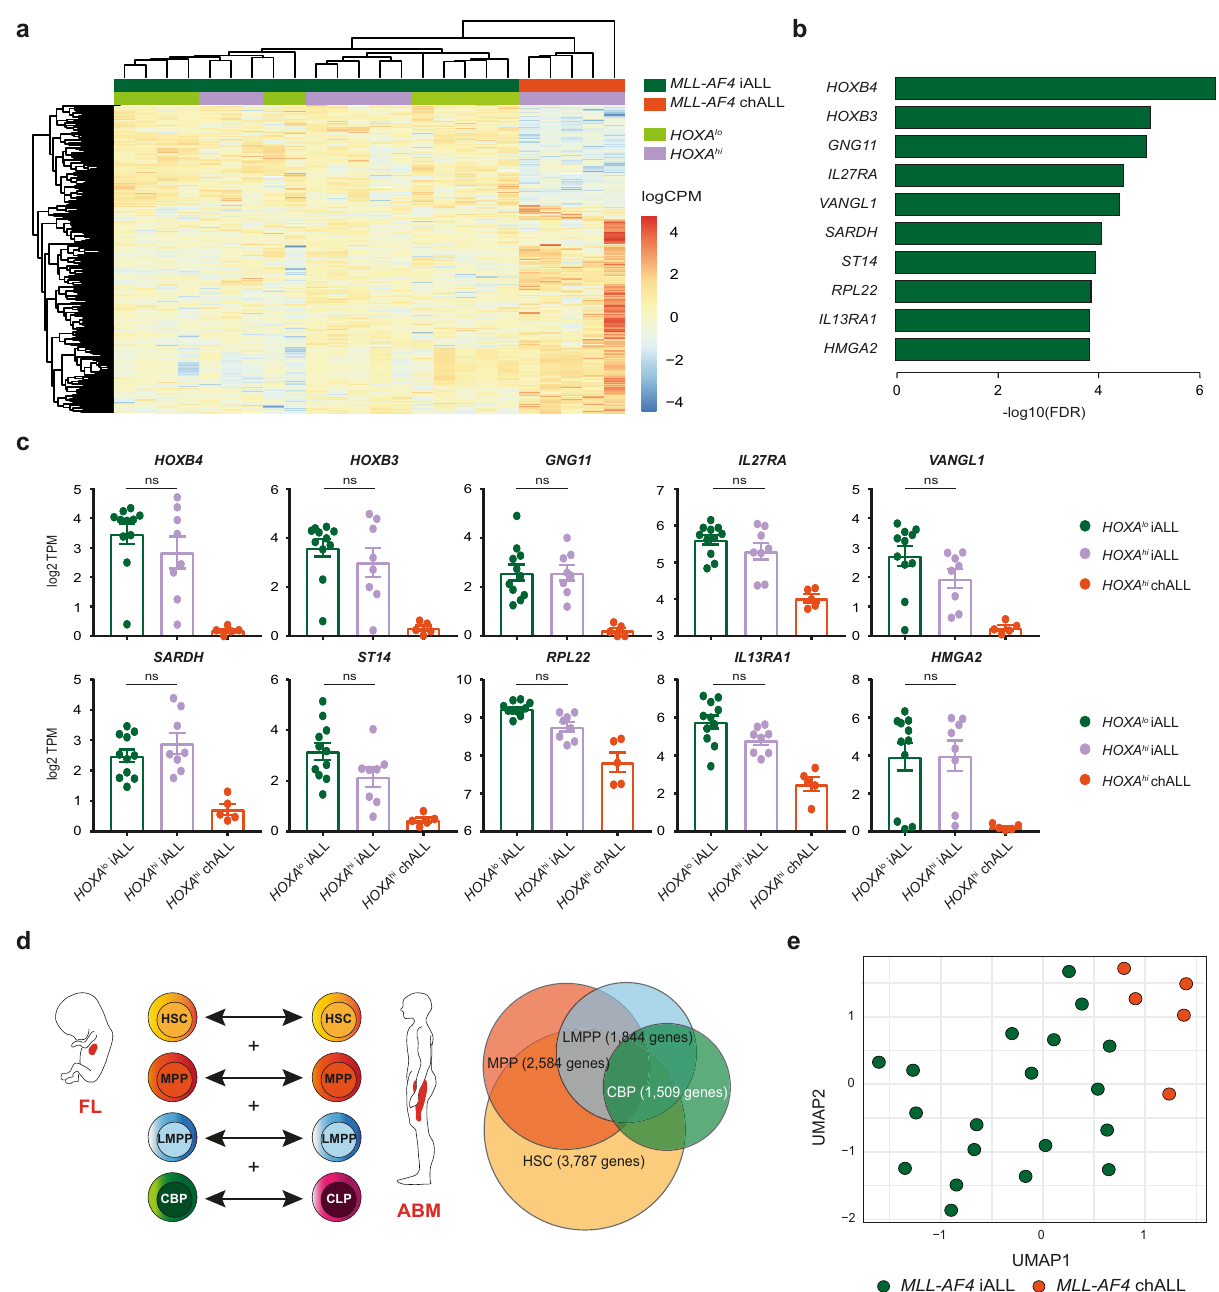
Fig. 1 Fetal gene expression programs drive the distinct molecular pro fi le of MLL-AF4 infant-ALL. a Heatmap showing clustering of MLL-AF4 infant-ALL (iALL (dark green), n = 19) and MLL-AF4 childhood-ALL (chALL (orange), n = 5) based on 617 signi fi cantly differentially expressed genes (FDR < 0.05, edgeR exact test; Supplementary Data 1). HOXA lo (light green, n = 11) and HOXA hi (purple, n = 13) MLL-AF4 subsets of infant-ALL and childhood-ALL are annotated. Color scale = log 2 counts per million (logCPM). b Bar plot showing signi fi cance ( − log10(FDR)) for the ten most signi fi cantly upregulated genes in MLL-AF4 infant-ALL. c Expression (log 2 transcripts per million (log 2 TPM)) of the top ten most signi fi cantly upregulated genes in MLL-AF4 infant-ALL in HOXA lo MLL-AF4 infant-ALL (iALL (light green), n = 11), HOXA hi MLL-AF4 infant-ALL (iALL (purple), n = 8), and HOXA hi MLL-AF4 childhood-ALL (chALL (orange), n = 5). Data are shown as mean ± SEM (n.s.: p > 0.05; one-way ANOVA with Tukey ’ s correction for multiple comparisons). Source data are provided as a Source Data fi le. d (left) Schematic representation of differential gene expression analysis between FL and ABM. Equivalent HSPC subpopulations were compared and signi fi cantly differentially expressed genes (FDR < 0.05, edgeR exact test) for all four comparisons were combined into a master list of genes that were differentially expressed in at least one HSPC subpopulation (HSC hematopoietic stem cell, MPP multipotent progenitor cell, LMPP lymphoid-primed multipotent progenitor cell, CBP committed B progenitor, CLP common lymphoid progenitor). (right) Venn diagram showing overlap of differentially expressed genes for each HSPC subpopulation (Supplementary Data 2). e UMAP showing clustering of MLL-AF4 infant-ALL (iALL (dark green), n = 19) and MLL-AF4 childhood-ALL (chALL (orange), n = 5) from a previously published patient dataset 23 based on 5709 genes differentially expressed between FL HSPCs and ABM HSPCs (Supplementary Data